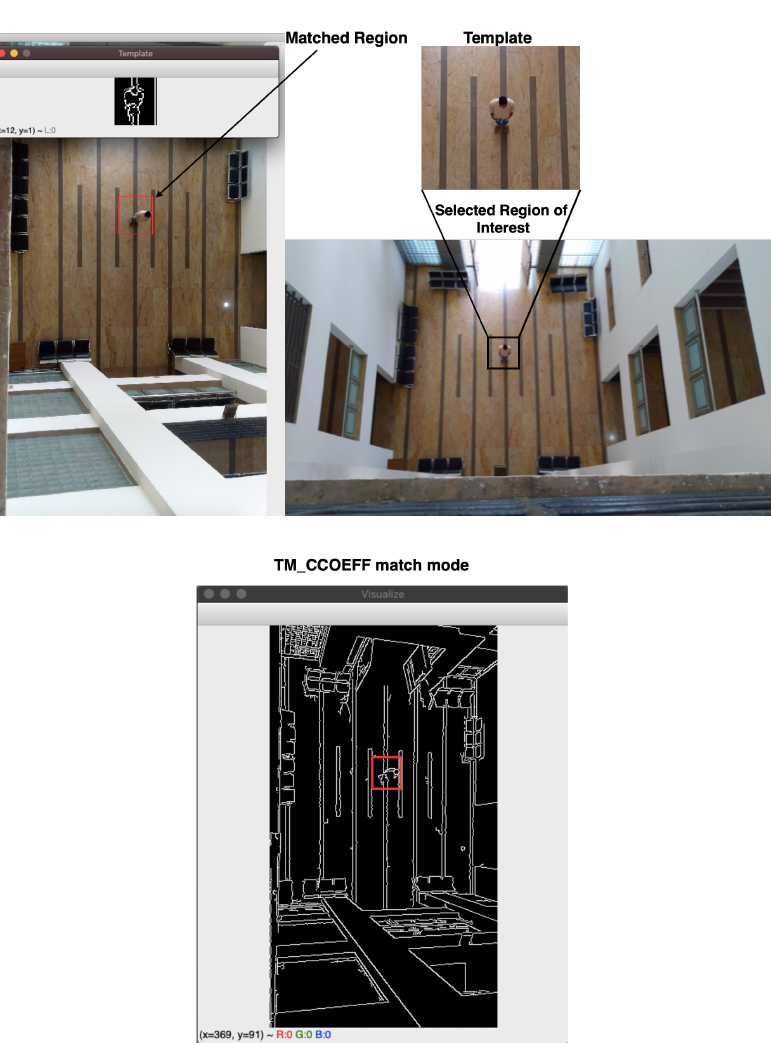
Figure 4. RoI-based template extraction from a master drone image and matching—identifying the tracking region in another drone image heading in the same